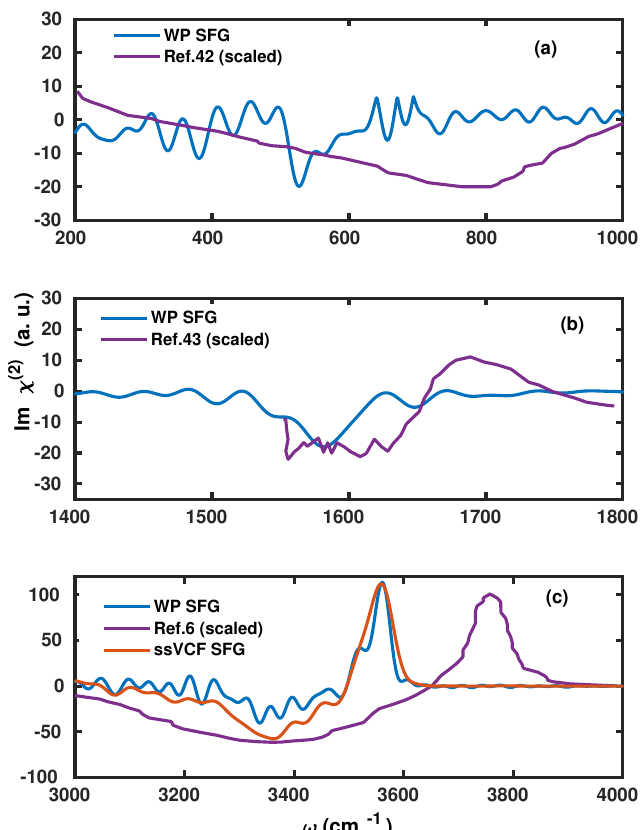
Figure 4. Comparison between the vSFG spectra as obtained using our WP method and experimental and theoretical measurements of ( a ) librational, ( b ) bending, and ( c ) stretching modes, respectively. The intensities of the experimental references were rescaled to match the theoretically obtained